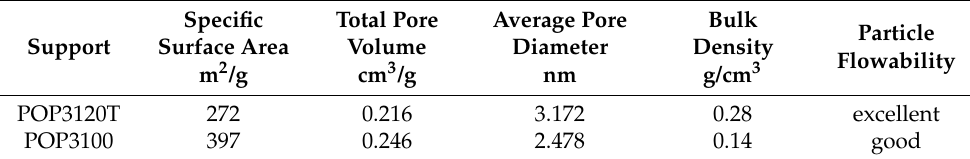
Table 1. Porosimetry analysis from N 2 sorption and bulk density results.